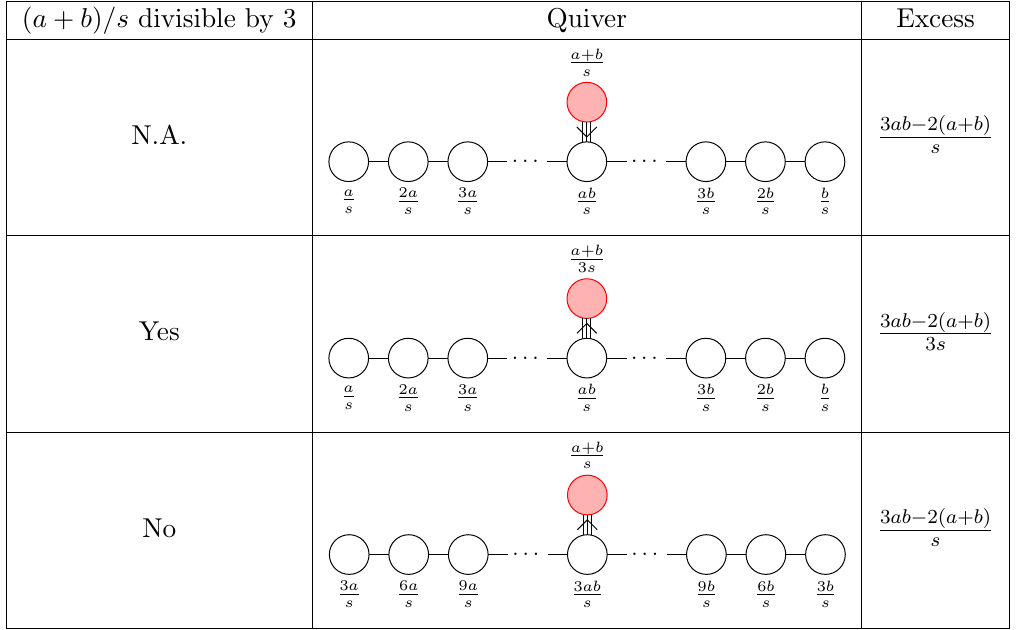
Table 13 . Exotic minimally unbalanced quivers with G = SU( n ), n = a + b and a triple laced edge. s is the greatest common divisor of a and b .